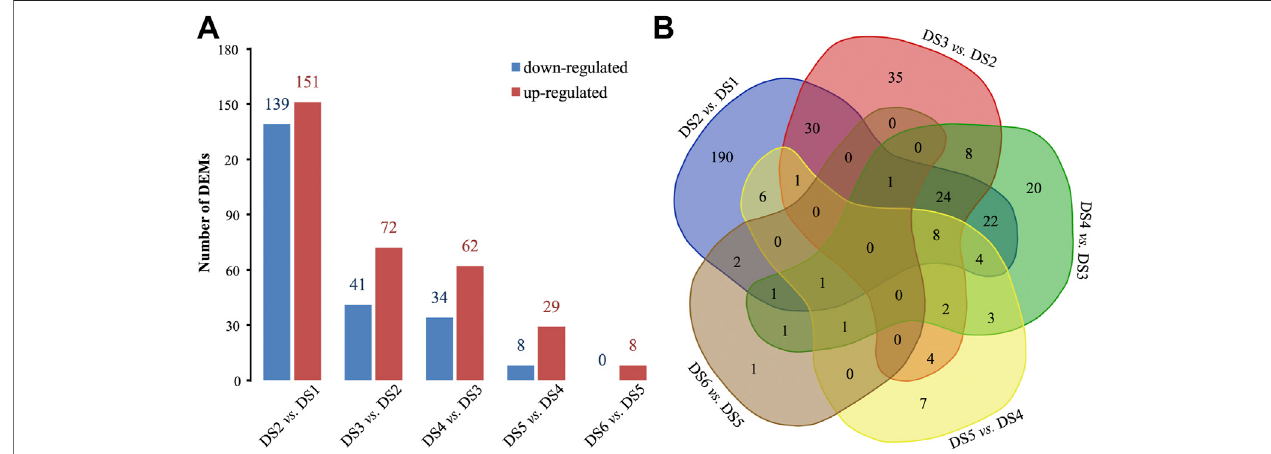
FIGURE 3 | Pairwise comparisons to identify differentially expressed miRNAs (DEMs) between adjacent stages. (A) The bar plot statistic and (B) a Venn diagram.